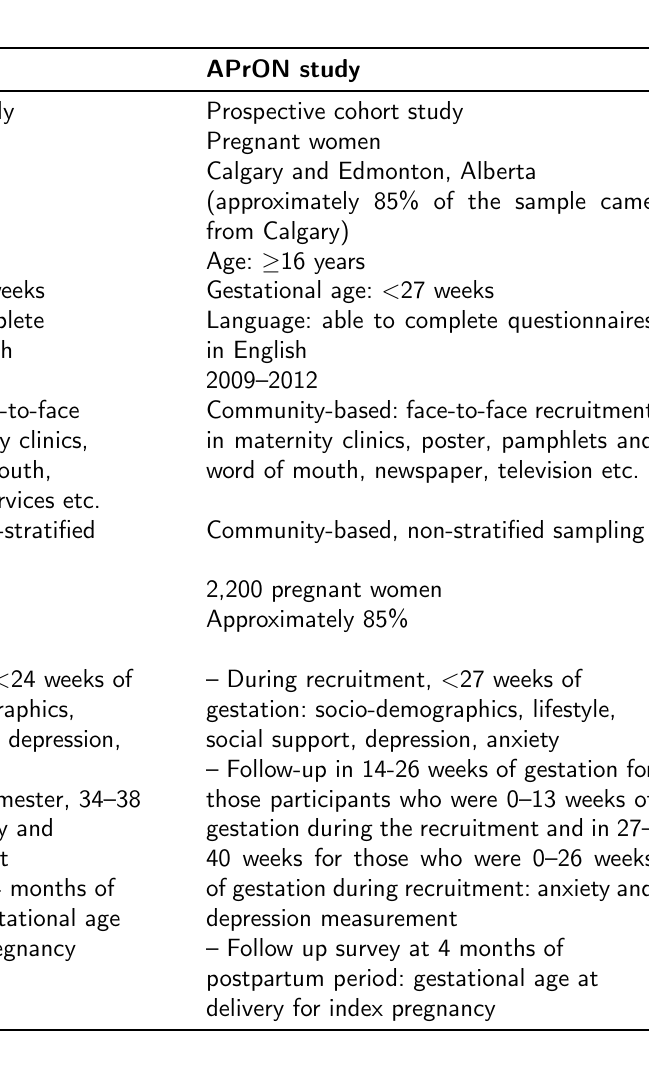
Supplementary Table 1: Characteristics of All Our Family (AOF) and Alberta Pregnancy Outcomes and Nutrition (APrON)